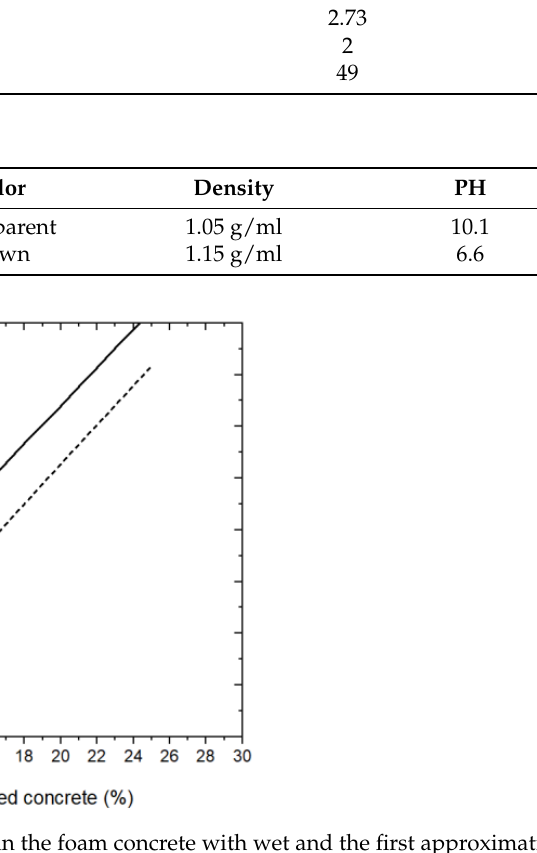
Figure 1. Voluminous content of paste in the foam concrete with wet and the first approximation of air-dry air-dry density.